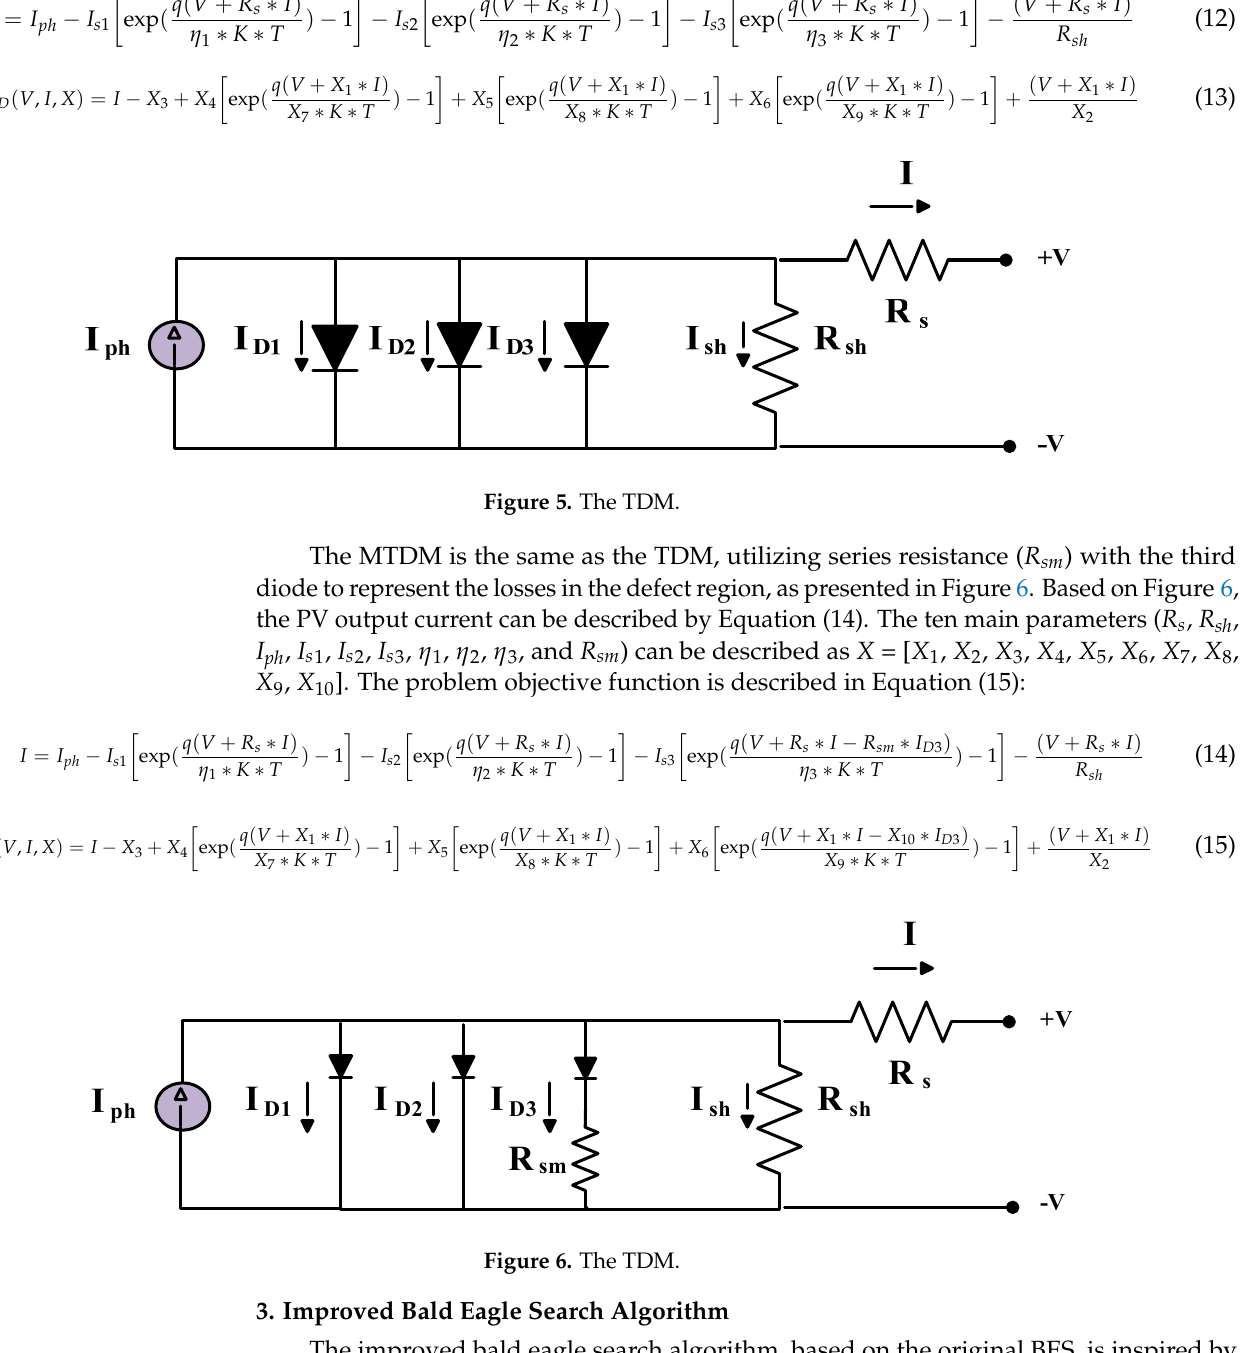
( b ) Figure 7. ( a ) Behavior of bald eagle during hunting; ( b ) sequential stages of bald eagle hunting. -